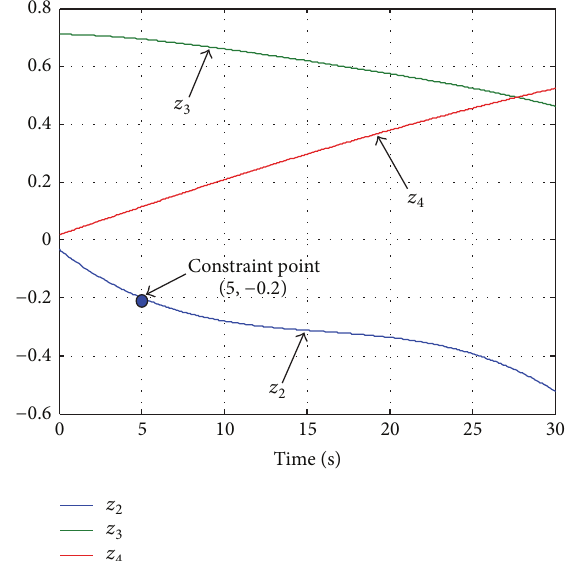
𝑧 with one constraint point.